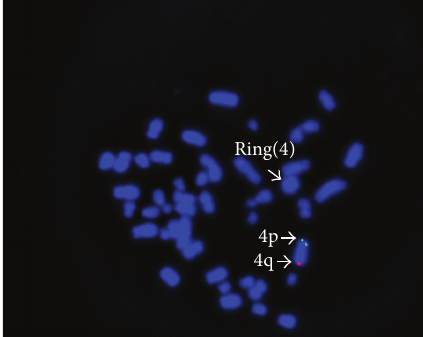
Figure 3: FISH study using a WHS critical region probe (red signal) and chromosome 4q subtelomere specific control probe (green signal) shows the presence of WHS critical region on both normal and ring chromosomes 4.